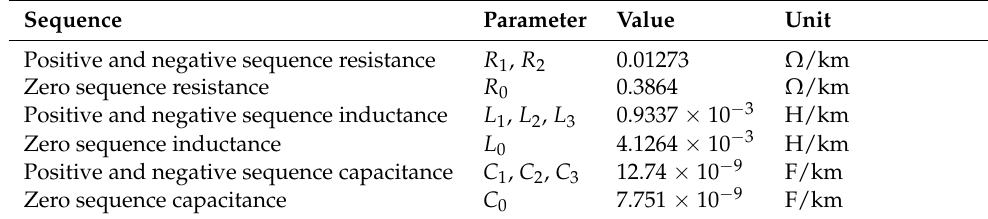
Table 1. Parameters of 330 kV, 500 km transmission line.